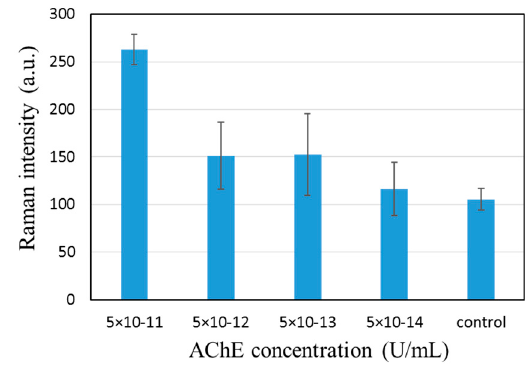
Figure 6. Bar graph showing the effect of pre-concentration on the intensity of the 768 cm − 1 peak and its dependence on the AChE concentration. The peak can be observed even with AChE concentration of 5 × 10 − 13 U/mL with 10 − 4 M